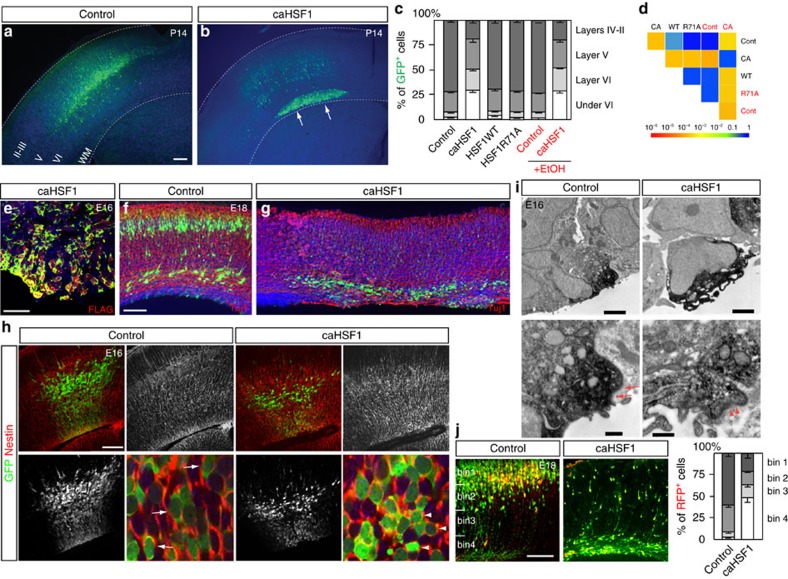
Excess activation of Hsf1 causes heterotopia formation.(a,b) The P14 cortex electroporated with the control (a) or caHSF1 expression (b) plasmid at E14. caHSF1 expression causes the formation of periventricular heterotopia. Blue: nuclei counter staining. (c) Distribution of GFP+ electroporated cells transfected with indicated constructs. Data are represented as mean±s.e.m. F(3,48)=1197, P<0.0001 by repeated measures ANOVA among groups without EtOH exposure. P<0.001 by post hoc Tukey test between caHSF1 and other HSF1 forms or control. F(3,24)=80.59, P<0.0001 between caHSF1 and control comparison under EtOH exposure. (d) Pairwise comparisons of cumulative radial distributions using Kolmogorov–Smirnov (K–S) test. Each P-value is shown in a color according to the scale at the bottom. (e) Confirmation of caHSF1 (with a FLAG-tag) expression in the GFP+ electroporated cells by FLAG immunohistochemistry. Blue: nuclei counter staining. (f–h) Tuj1 (f,g) and Nestin (h) immunohistochemistry at indicated ages following IUE at E14. Arrows and arrowheads in h indicate oval-shaped, radially oriented NPCs in the control, and abnormal round-shaped, non-radially oriented caHSF1-expressing NPCs, respectively in the VZ. (i) Immuno-electron microscopy of control- and caHSF1-electroporated NPCs at the ventricular surface. Electroporated cells were visualized by GFP immunohistochemistry using DAB (black). Complete loss of adherens junctions is accompanied by the detachment of caHSF1-expressing NPCs from surrounding non-electroporated cells. The remaining disorganized adherens junctions are revealed by decreased electron density (arrowheads) compared with normal adherens junctions in the control (arrows). (j) Using the CALSL/Tα1-Cre system, exogenous genes (RFP only (control) or RFP plus caHSF1) were expressed exclusively in immature neurons. The GFP plasmid (pCAGIG) also was introduced to label all electroporated cells (n=6 embryos). caHSF1 expression interferes radial migration of neurons cell-autonomously. Radial distribution of RFP+ neurons (graph) shows significant difference between control and caHSF1 electroporation (F(3,24)=244.3, P<0.0001 by repeated measures ANOVA. P<0.0001 by K-S test). Data are represented as mean±s.e.m. Scale bars, 0.3 (a,b), 0.04 (e) and 0.2 (f–h,j) mm, and 5 (i, upper panels) and 0.2 (i, lower panels) μm.